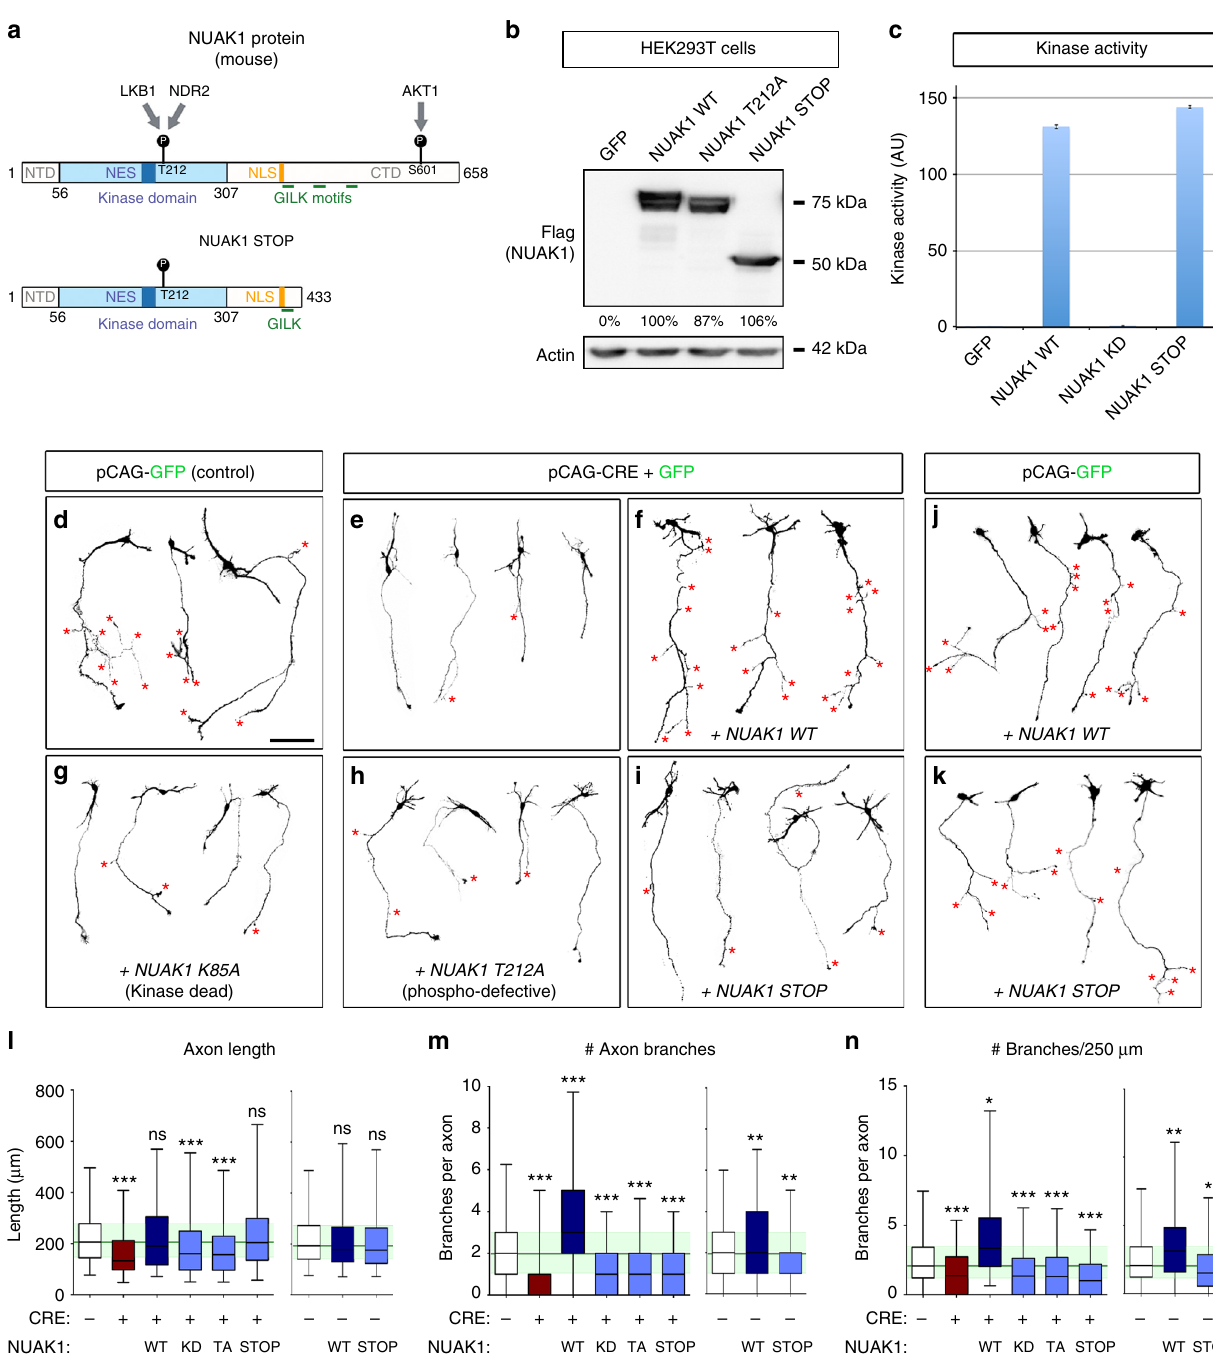
Fig. 7 Functional analysis of NUAK1 mutations through a protein-replacement strategy. a Structure of the NUAK1 protein (mouse) and predicted structure of the Q434STOP mutant. Known or predicted domains are indicated. NTD: N-terminal domain. CTD: C-terminal domain. NES: Nuclear Export Sequence (predicted). NLS: Nuclear Localization Sequence (predicted). b Validation of NUAK1 mutant expression in HEK293T cells by western-blot. c In vitro measurement of kinase activity of wild type or mutant NUAK1. d – k Representative neurons imaged after 5DIV following ex vivo electroporation of the indicated plasmids in NUAK1 F/F animals. Neuron morphology was visualized through mVenus expression. Red stars (*) points to branch position. Scale bar: 100 μ m. l – n Quanti fi cation of axon length ( l ), number of branches per axon ( m ) and normalized branch number ( n ) in neurons from ( d – k ). Quanti fi cations were normalized to the average value of Control (CTL) condition to allow comparison of distinct, independent experiments. Data represents min, max, median, 25 th , and 75 th percentile. N CTL = 189, N CRE = 138, N CRE + WT = 90, N CRE + KD = 150, N CRE + TA = 174, N CRE + STOP = 125, N WT = 134, N STOP = 198. Analysis: Kruskal – Wallis test with Dunn ’ s multiple comparison. ns: p > 0.05, * p < 0.05, ** p < 0.01, *** p <